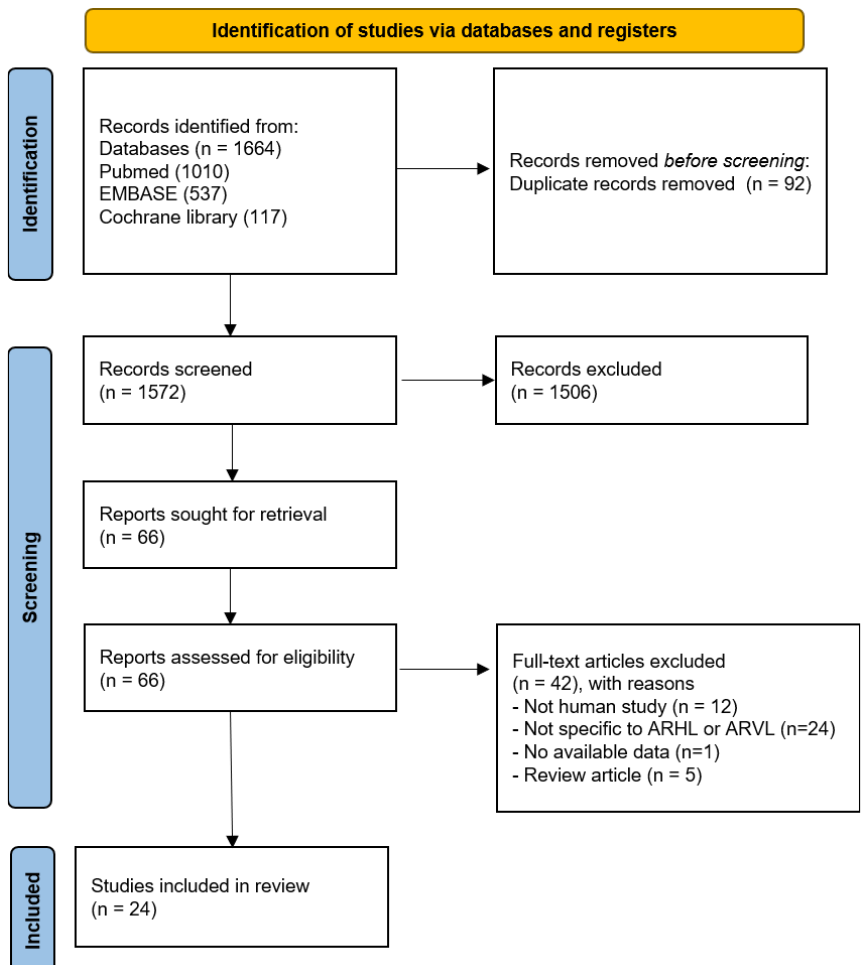
Figure 1. Flow diagram of literature research.